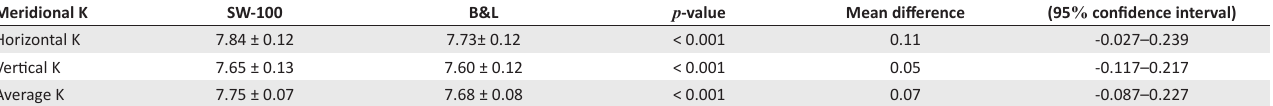
TABLE 1: Mean (±s.d.) readings (in mm) with the SW-100 and Bausch & Lomb keratometers and 95 % confidence intervals of the mean differences ( N = 80 right eyes of 80 subjects). Meridional K SW-100 B&L p -value Mean difference (95 % confidence interval) Horizontal K 7.84 ± 0.12 Vertical